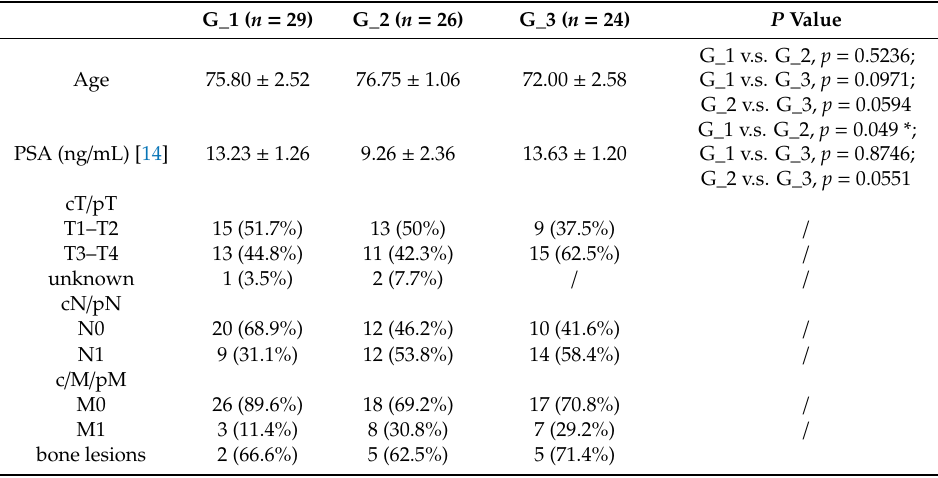
Table 2. Baseline characteristics of